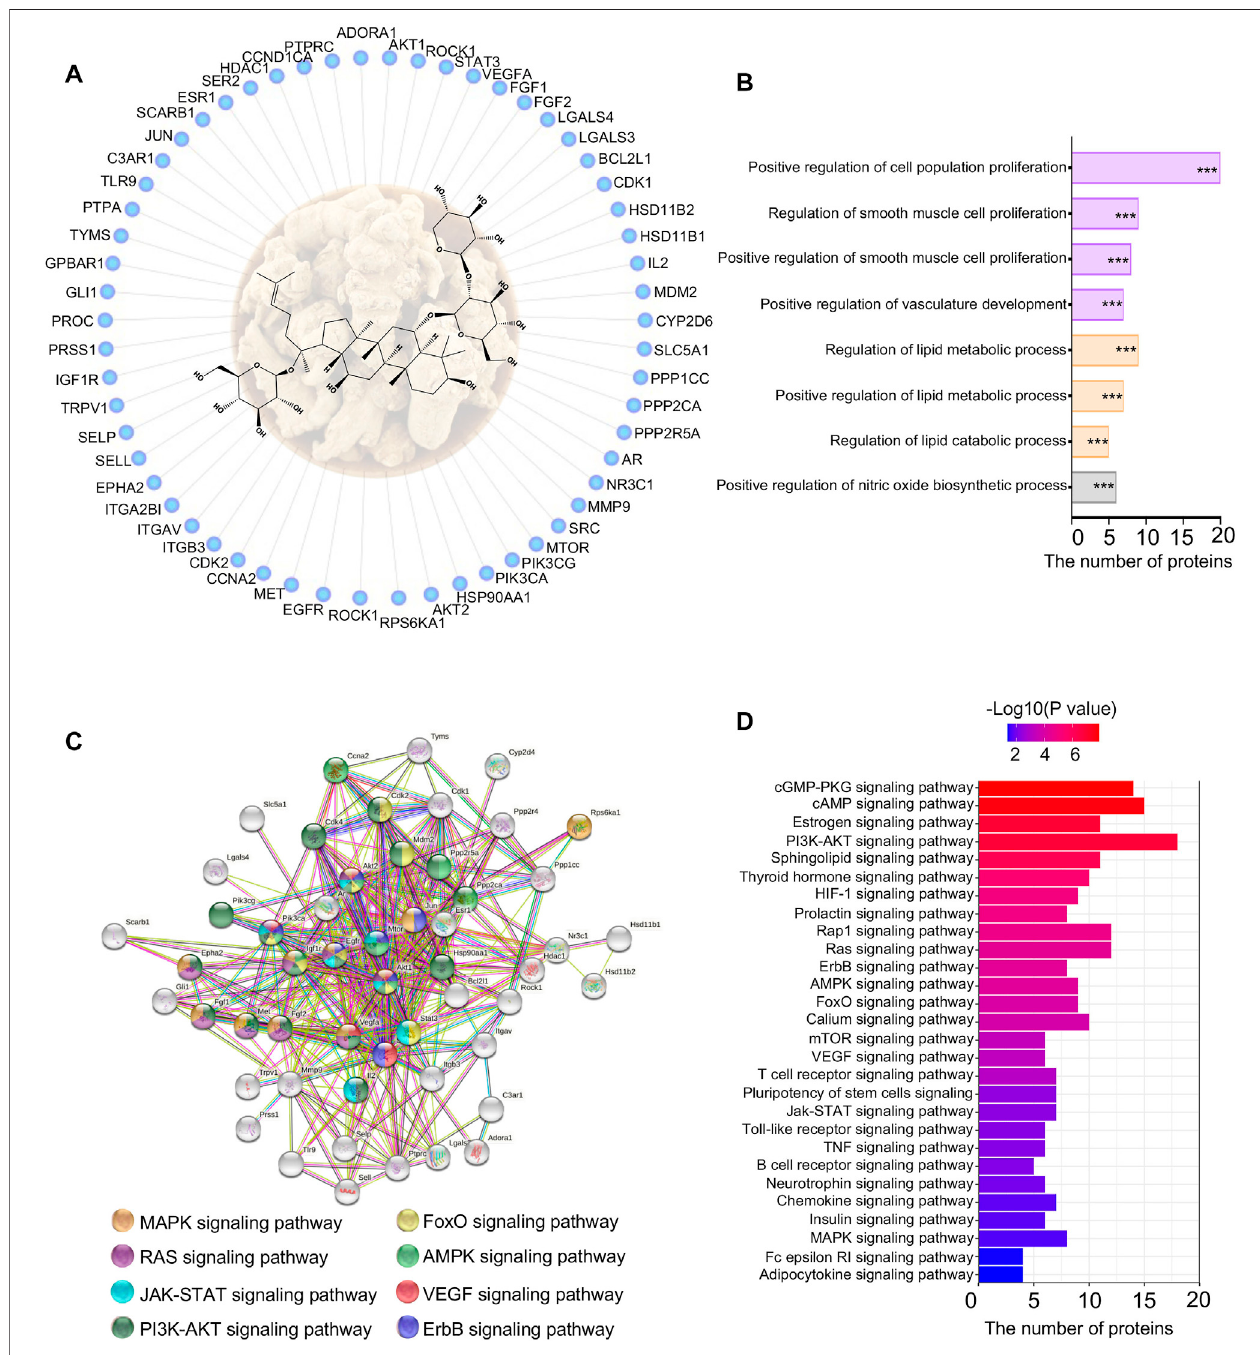
FIGURE 4 | Network pharmacology of NGR1. (A) Reverse-docked targets of NGR1; (B) Functional annotation of reverse-docked targets. These reverse-docked targets were annotated by GO terms. The pathways were evaluated by a false-positive rate, * F < 0.05, ** F < 0.01, and *** F < 0.001. (C) Functional target association network by String analysis. (D) Functional annotation of reverse-docked targets by KEGG terms.